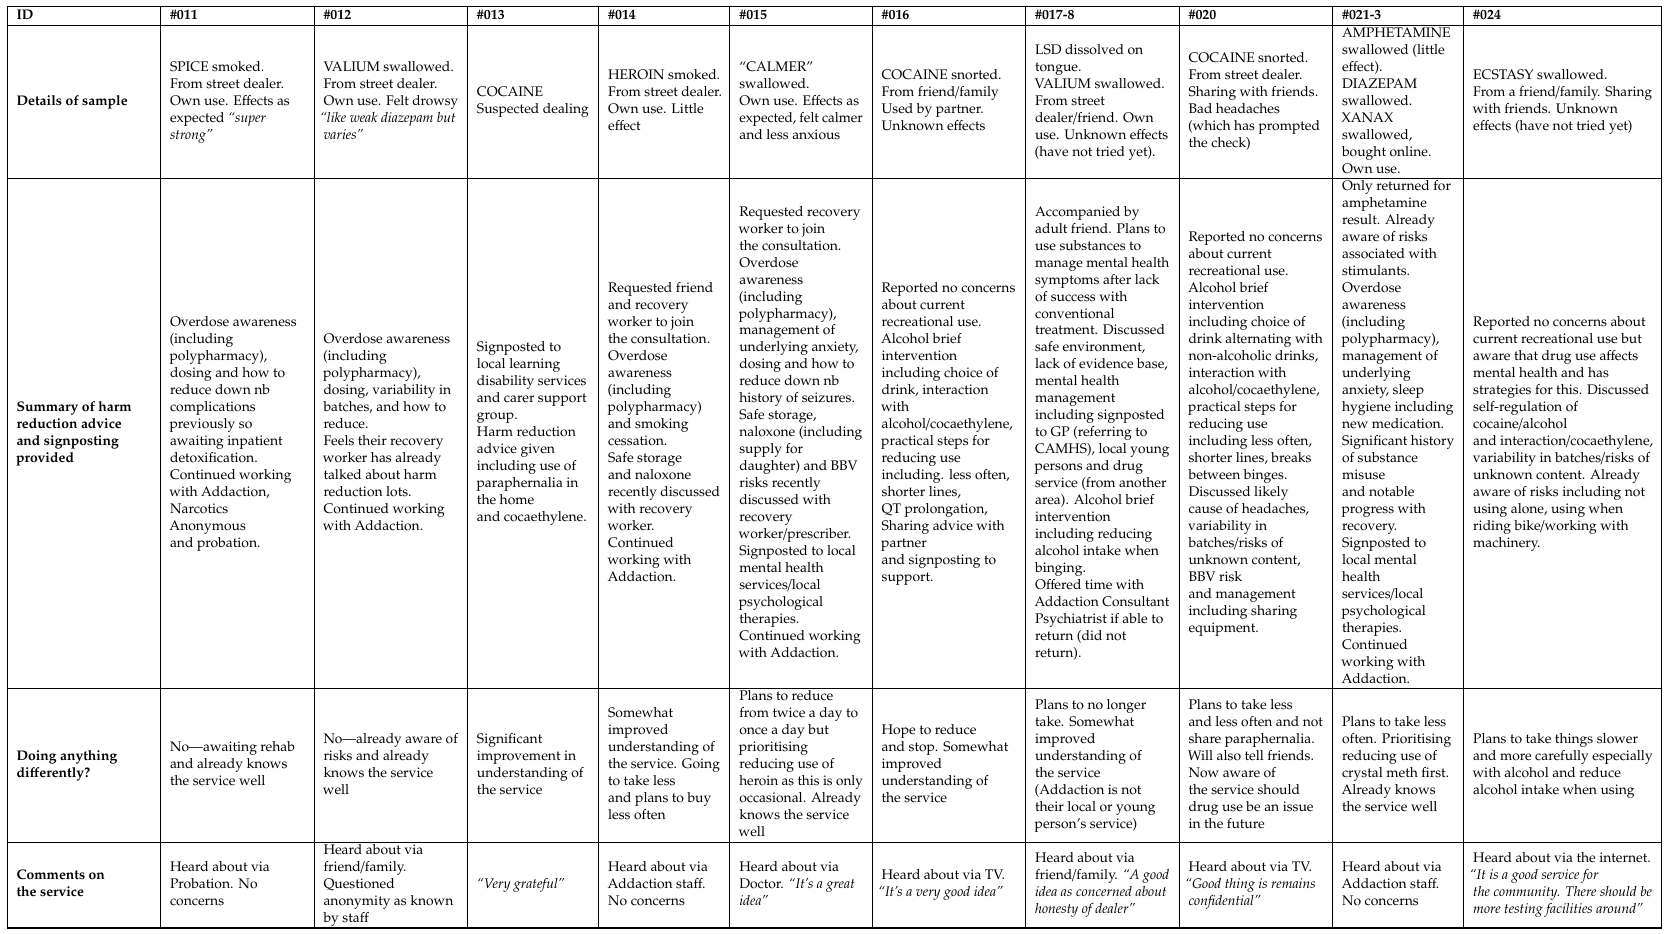
Table 2. Summary of results about the relinquished sample and harm reduction